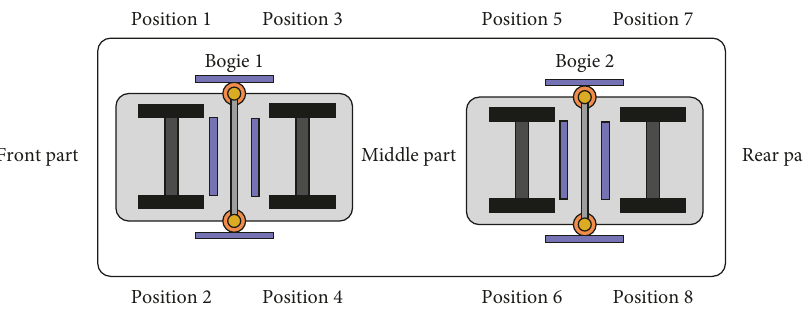
Figure 5: The structure of the high-speed train bogie and the location of sensors.